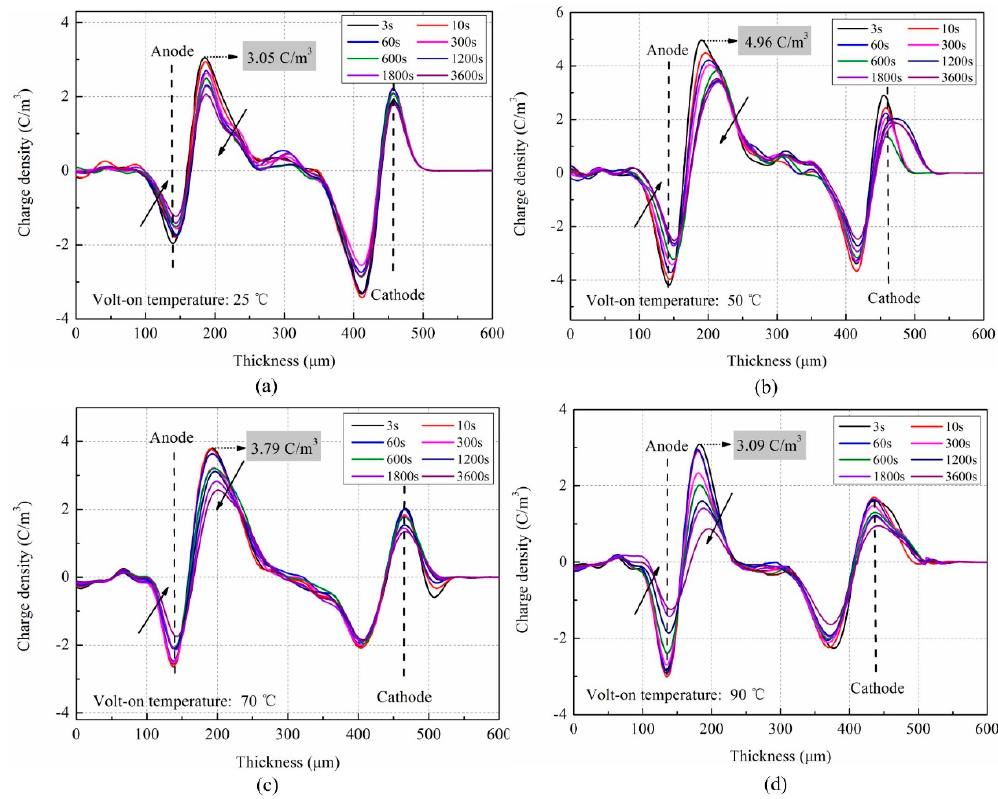
Figure 3. Space charge decay profiles in LDPE polarized at different temperatures. ( a ) 25 °C; ( b ) 50 °C; ( c ) 70 °C; ( d ) 90 °C.